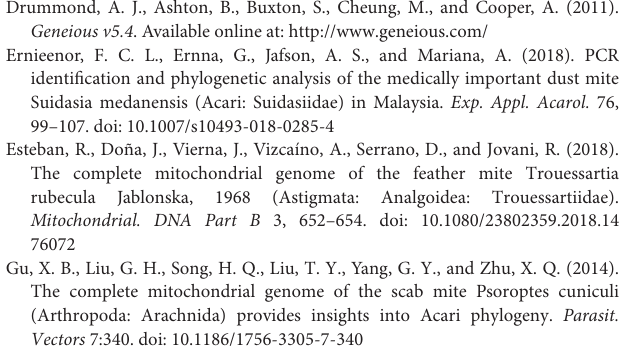
Supplementary Figure 1 | Circular genome sequences of the Astigmata were linearized at the 5 ′ end of the cox1 gene. Genes transcribed in the same direction as cox1 (left to right) are shown above the line, and genes transcribed in the opposite direction are shown below the line. Gene sizes are not drawn to scale. Supplementary Figure 2 | Predicted secondary structure of 22 tRNA. Supplementary Table 1 | Species used in this study. Supplementary Table 2 | Mitochondrial genome organization of Suidasia